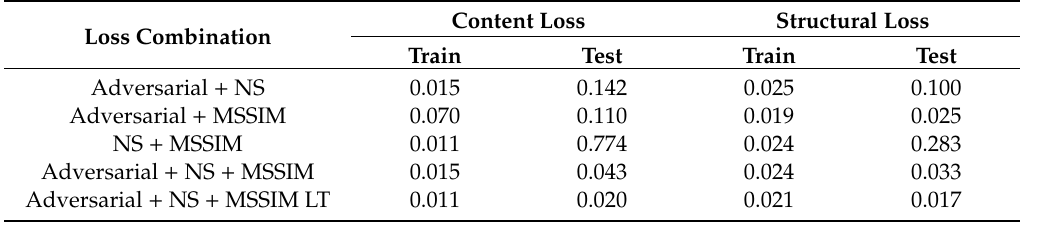
Figure 3. Temporal median of AOGCM annual maximum precipitation of ( a ) BCC ESM, ( b ) CAN ESM5, ( c ) CESM2, ( d ) CNRM CM6.1, ( e ) CNRM ESM2, ( f ) GFDL CM4, ( g ) HAD GEM3, ( h ) MRI, and ( i ) UK ESM1. Table 2. Performance of di ff erent objective functions for the model. The median of the last 50 iterations has been used to measure the